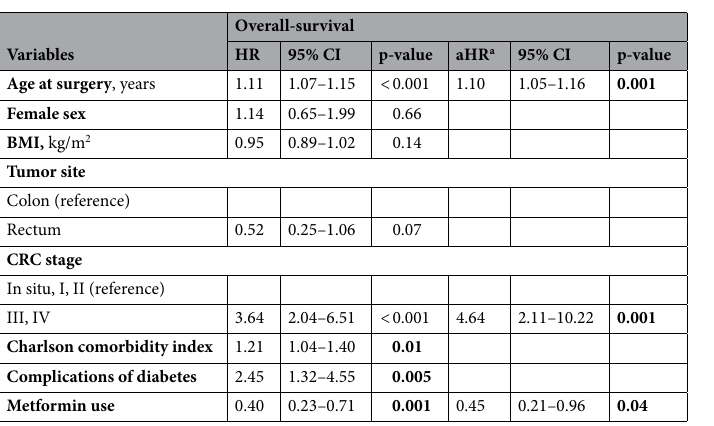
Table 3. Overall survival assessed by the Cox regression model. Significant values are in bold. HR, hazard ratio; CI, confidence interval. a Adjusted for age at surgery, sex, BMI, tumor site, CRC stage, Charlson comorbidity index, diabetes